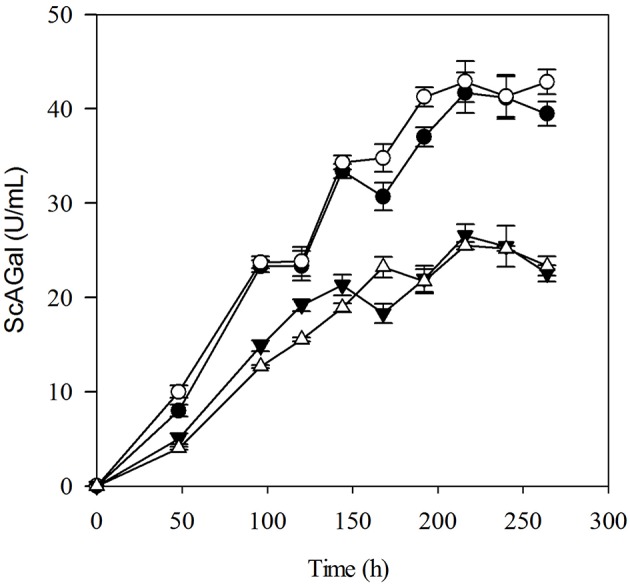
Time course of extracellular alpha-galactosidase activity using a conventional culture medium. Cultures in the YPHSM medium were inoculated to an OD600 of 0.5 from pre-cultures of strains BJ3505Δsuc2 (empty symbol) and BJ3505 (full symbol) transformed with the plasmids YEpMEL1 (circle), and YEpMEL1His (triangle).